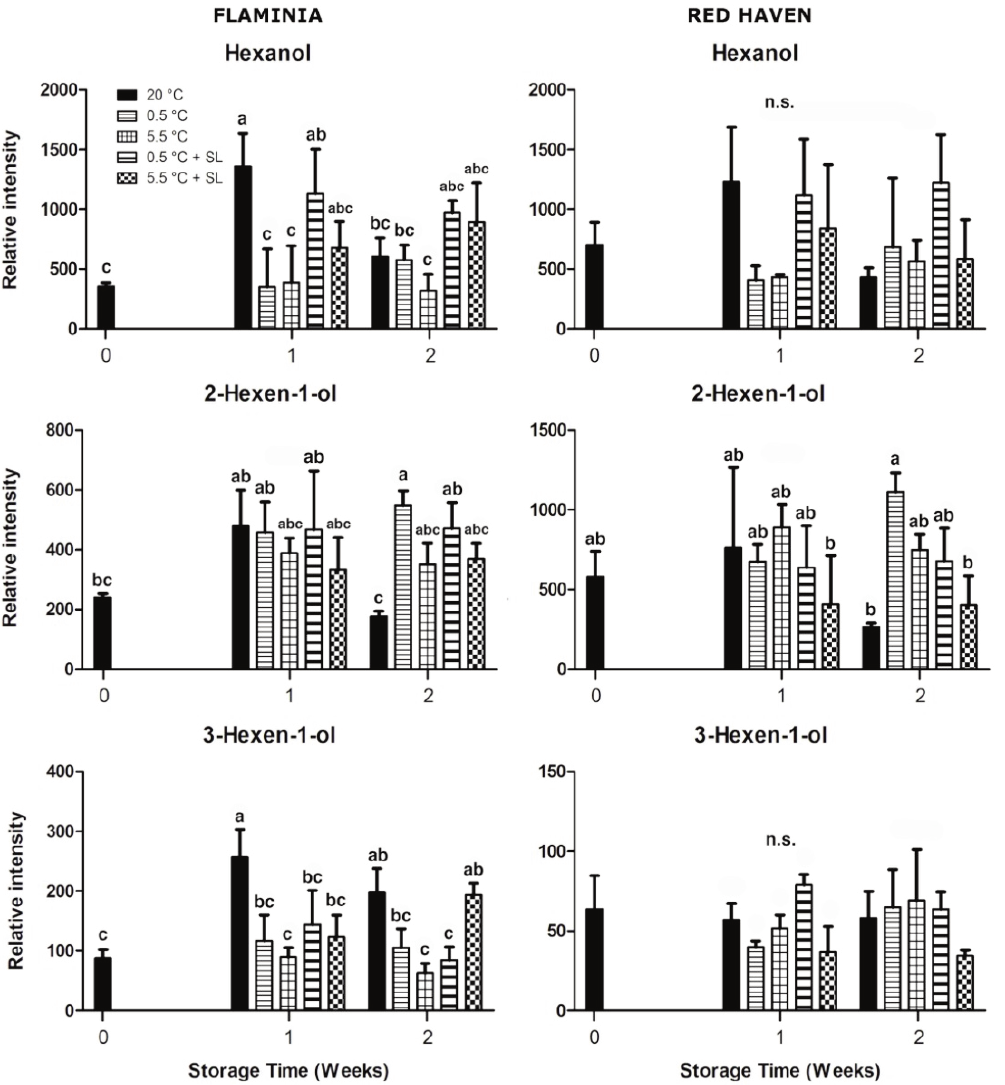
Fig. 2 ­ Analysis of targeted LOX pathway­derived alcohols. Mesocarp samples (cv. Flaminia, left panel; cv. Red Haven, right panel) were analysed at harvest (0), at the end of 1 and 2 weeks of cold storage at 0.5 and 5.5°C, and after three additional days of shelf life (0.5 and 5.5°C + SL). Samples kept at 20°C represent the room temperature control. The average value of three biological replica­ tes is reported with bars representing SD. Letters indicate the results of Tukey's Honest Significant Difference (HSD) post hoc test, performed independently for each